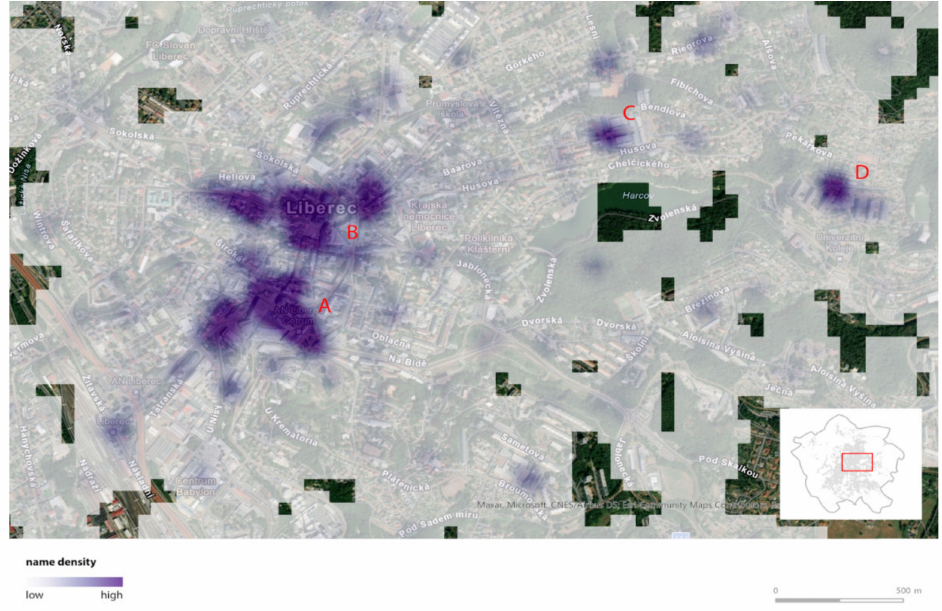
Figure 4. The highest concentration of names is in the area of the city center (clusters (A)—around the public transport terminal, “lower city center”, and (B)—around the town hall, “upper city center”). Another significant cluster is the university campus (C) and the university dormitory (D). Method used: Kernel Density, 100